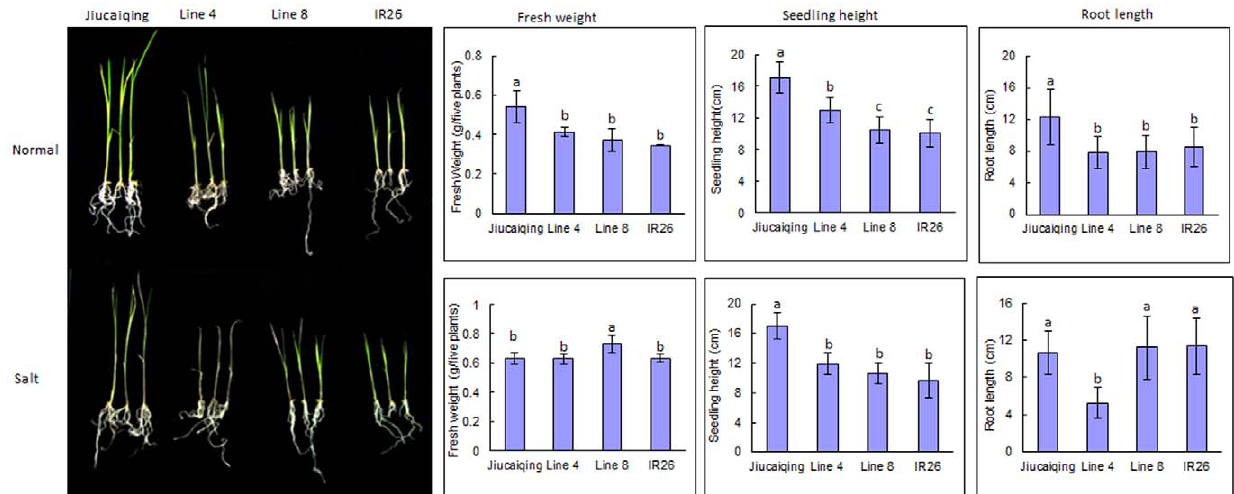
Figure 3. Effects of QTL qSNC11 on seedling salt tolerance.